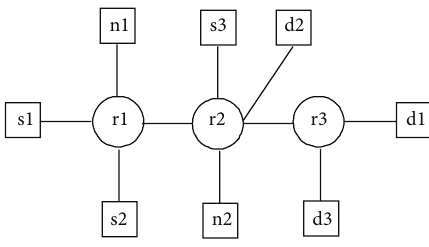
Figure 9: Topology with a varying bottleneck.